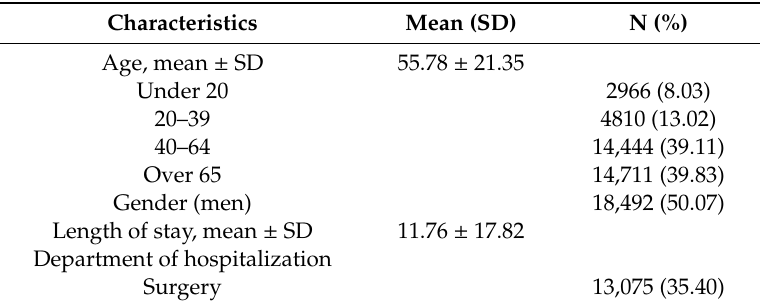
Table 1. Characteristics of the study population (N = 36,931)